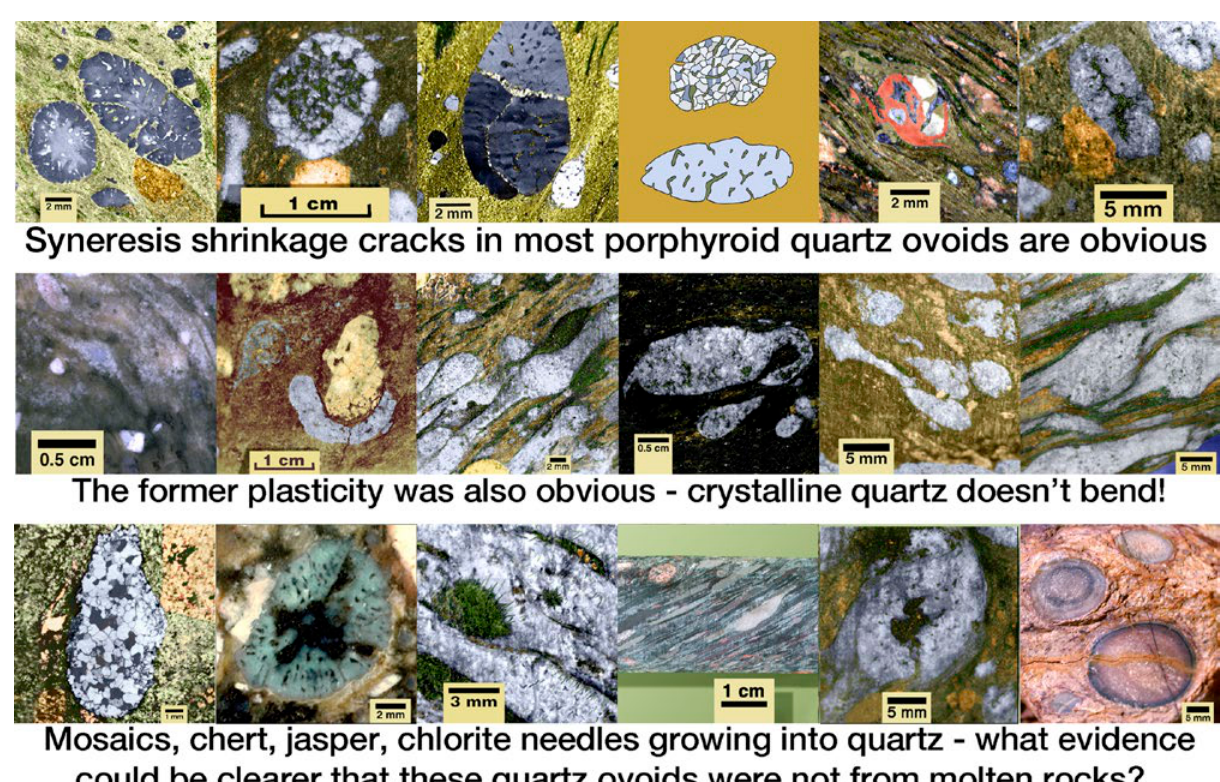
Figure 22. This illustrates the characteristic features of siliceous accretions in the Tennant Creek porphyroids. They include tubular synerec- tic crack patterns, plastic distortion, aggregation of sub units, chert, jasper, white and ’blue’ quartz rolled together, irregular fluidal contacts with feldspar and central shrinkage cavities filled with chlorite. This evidence for a non-molten or volcanic origin is conclusive (From Elli- ston 10 , 2014, p.